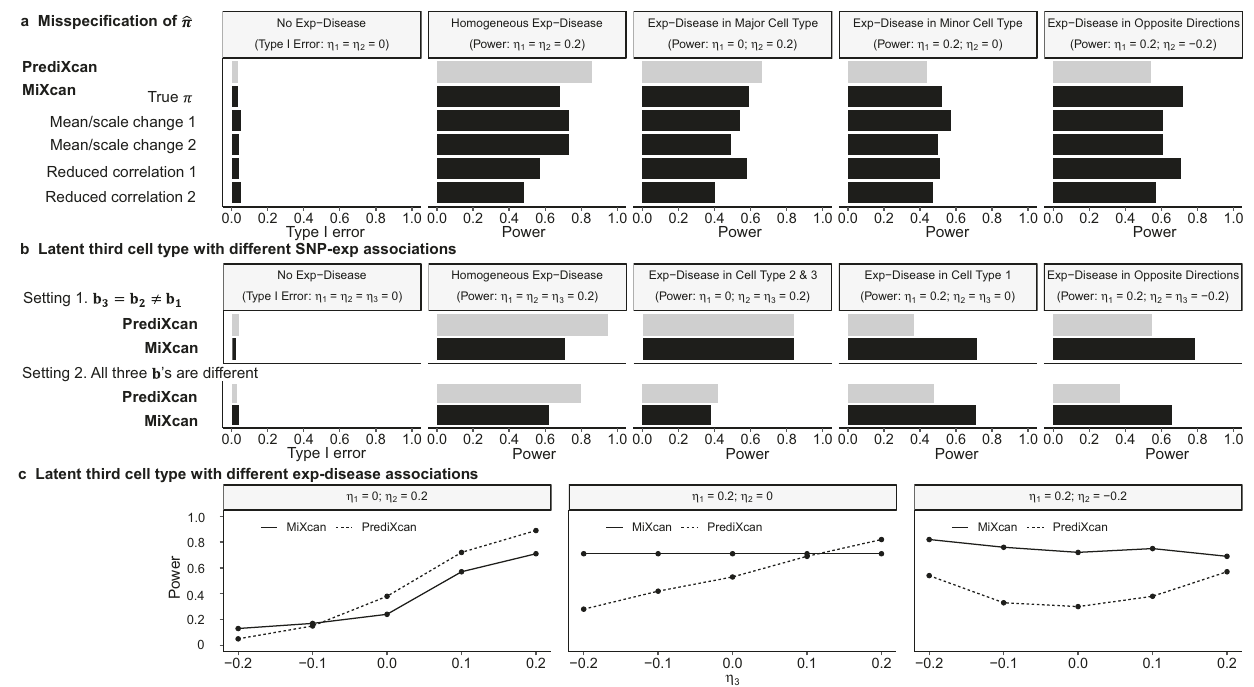
Fig. 5 | Simulation studies to assess the performance of MiXcan under model misspeci fi cation. a Type I error (column 1) and power (columns 2-5) when the estimated cell-type proportion ^ π used by MiXcan equals: the true π of 0.4; 0.8 π biasing the mean to 0.32 and changing the scale from (0, 1) to (0, 0.8) (mean/scale change 1); 0.7 π +0.2 biasing the mean to 0.48 and changing the scale to (0.2, 1) (mean/scale change 2); Beta (50 π ,50(1 − π )) reducing the correlation with π to 0.9 (reduced correlation 1); and Beta (5.5 π ,5.5(1 − π )) reducing the correlation with π to 0.6(reducedcorrelation2). b TypeIerror(column1)andpower(columns2 – 5)when